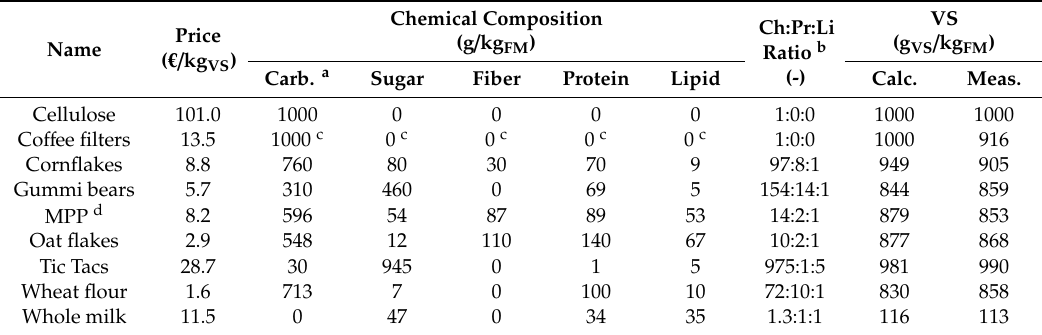
Table 1. Characteristics of microcrystalline cellulose and of substrates chosen as an alternative positive control. Price has been calculated based on the current supermarket price in Germany. from nutritional